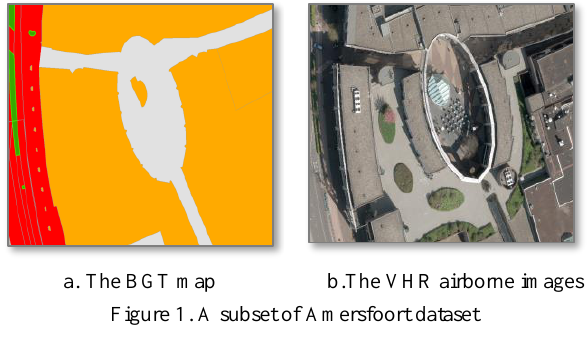
Figure 1. A subset of Amersfoort dataset